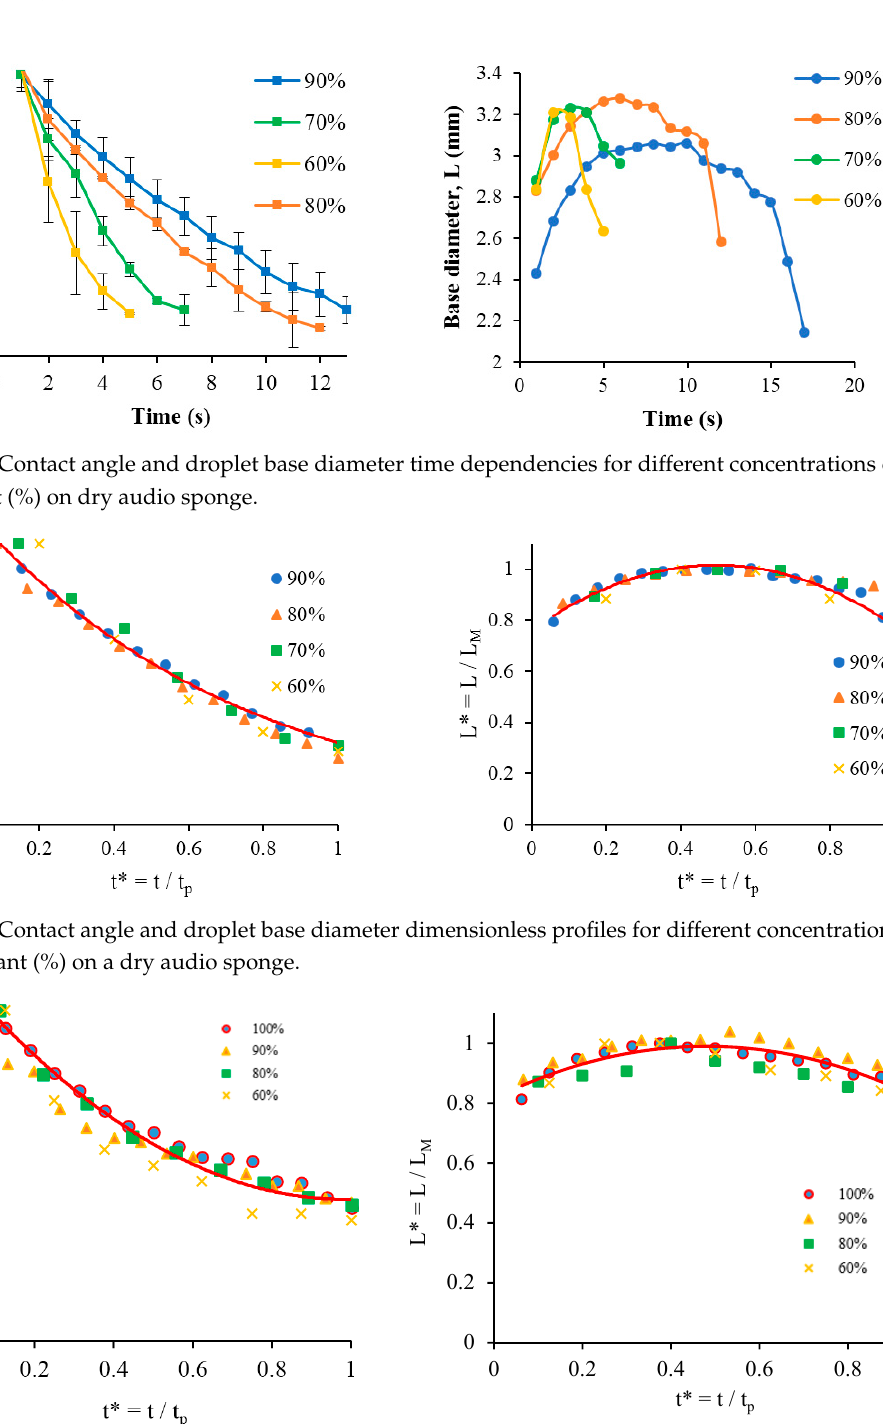
Figure 3. Contact angle and droplet base diameter time dependencies for distilled water on dry dish sponge. Both plots show the presence of stages 1 and 2 according to the partial wetting case in Figure 1.